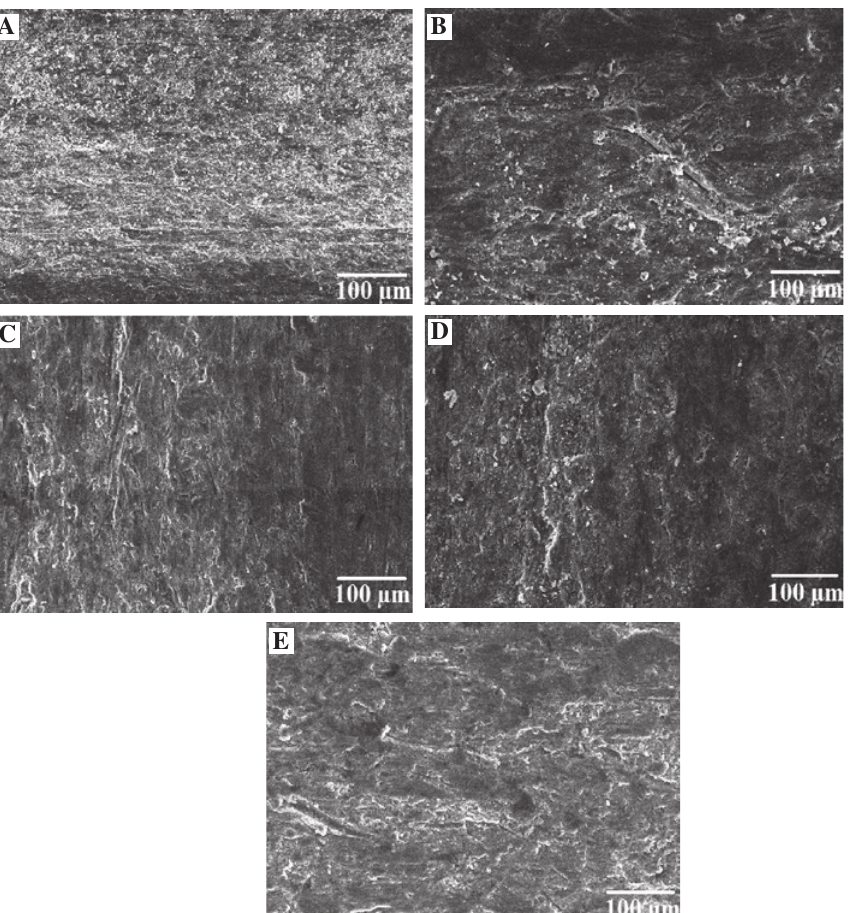
Figure 12: SEM micrographs of (A) middle FGM – 100 rpm (B) middle FGM – 150 rpm (C) middle FGM – 200 rpm (D) homogeneous composite at 200 rpm and (E) unreinforced alloy at 200